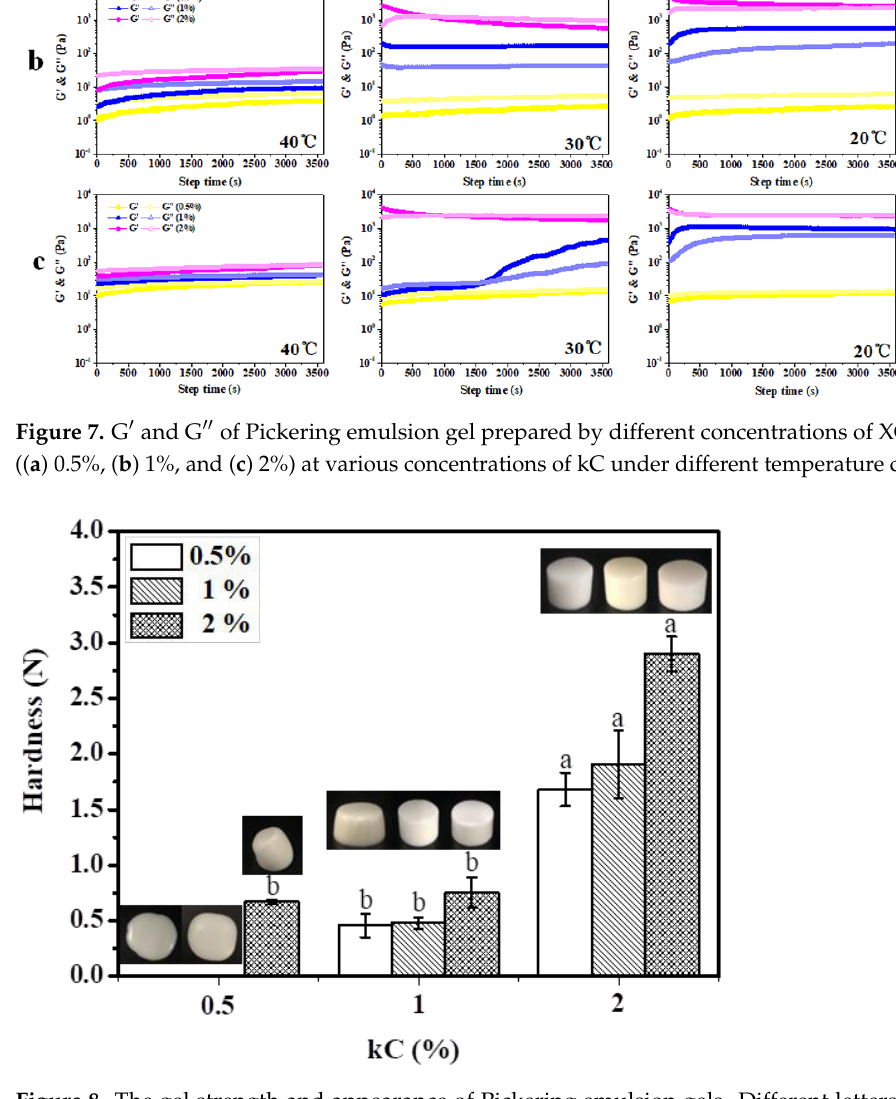
Figure 8. The gel strength and appearance of Pickering emulsion gels. Different letters represent significant differences ( p ≤ 0.05).